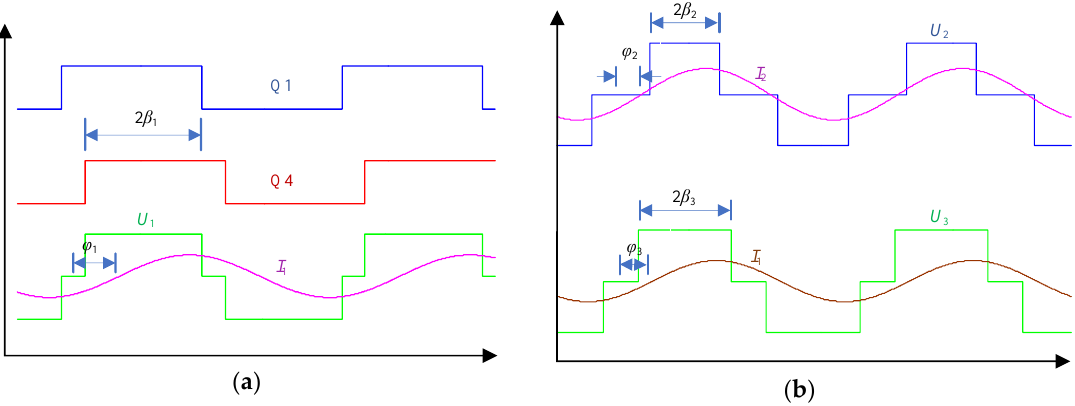
Figure 4. Drive signals, square-wave voltages and resonant currents waveforms in SS WPT system: ( a ) transmitter active bridge; ( b ) receiver active bridge.